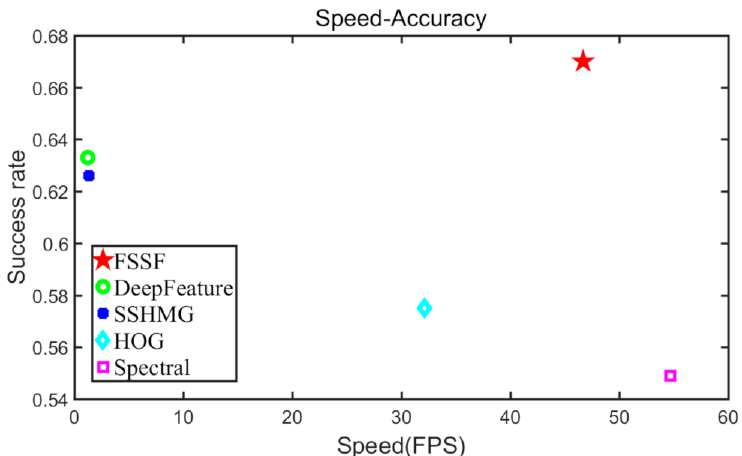
Figure 1. Tracking speed-accuracy plot of the same correlation filter tracker based on different features on a hyperspectral surveillance video (HSSV) dataset. The upper right corner indicates the best performance in terms of both standard and robust accuracy. The proposed FSSF algorithm achieves the best accuracy with faster